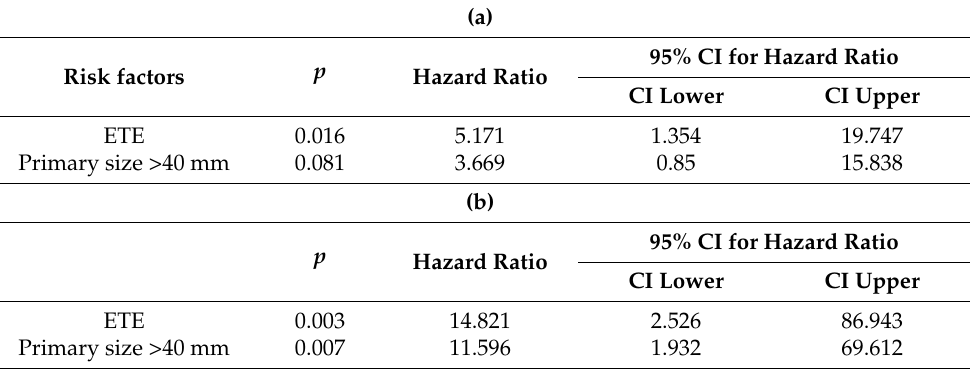
Table 4. ( a ) Multivariate model of risk factors for RAI-R TC at initial diagnosis. ETE = extrathyroidal extension; CI = confidential interval. ( b ) Multivariate model of risk factors for RAI-R TC during the course of disease. ETE = extrathyroidal extension; CI = confidential